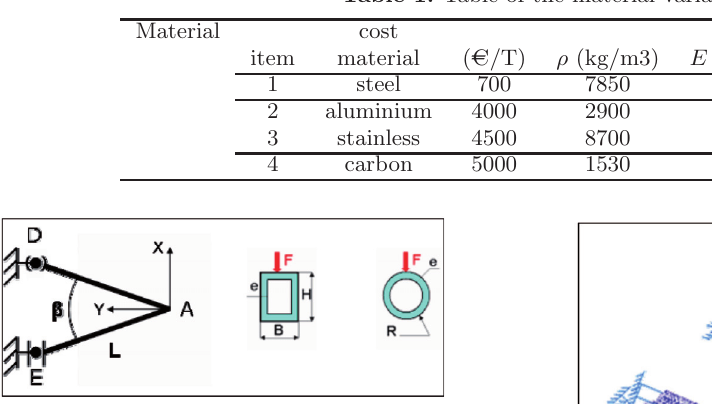
Table 1. Table of the material variation.